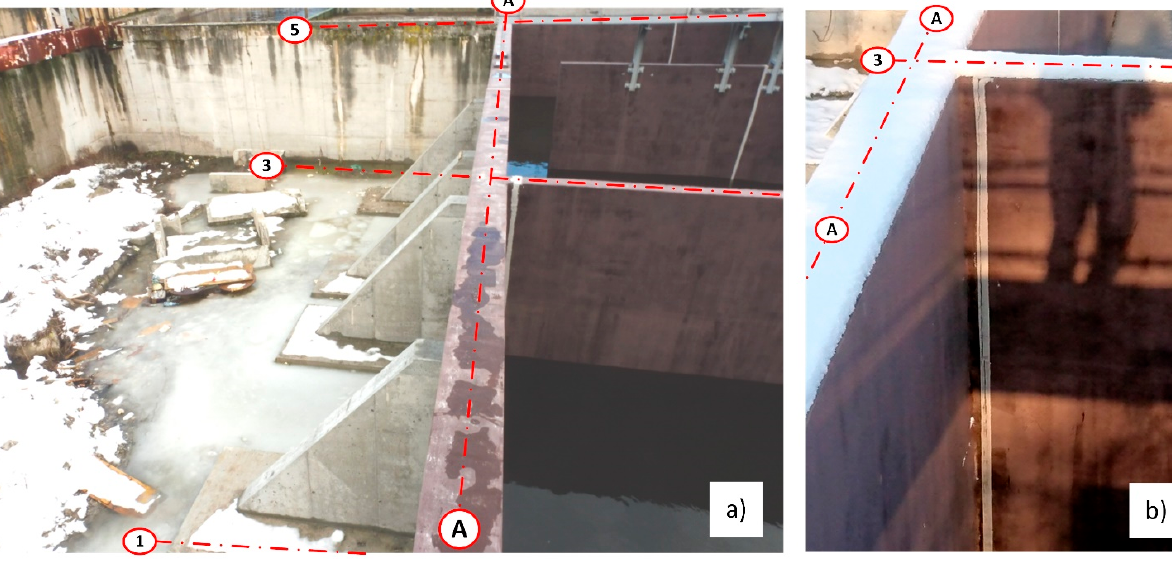
Figure 24. View of the strengthened wall of the bioreactor on axis A after the leak test, ( a ) view from the side of the supports; ( b ) view of the repaired expansion joint (dilatation) of the perpendicular wall in axis 3.